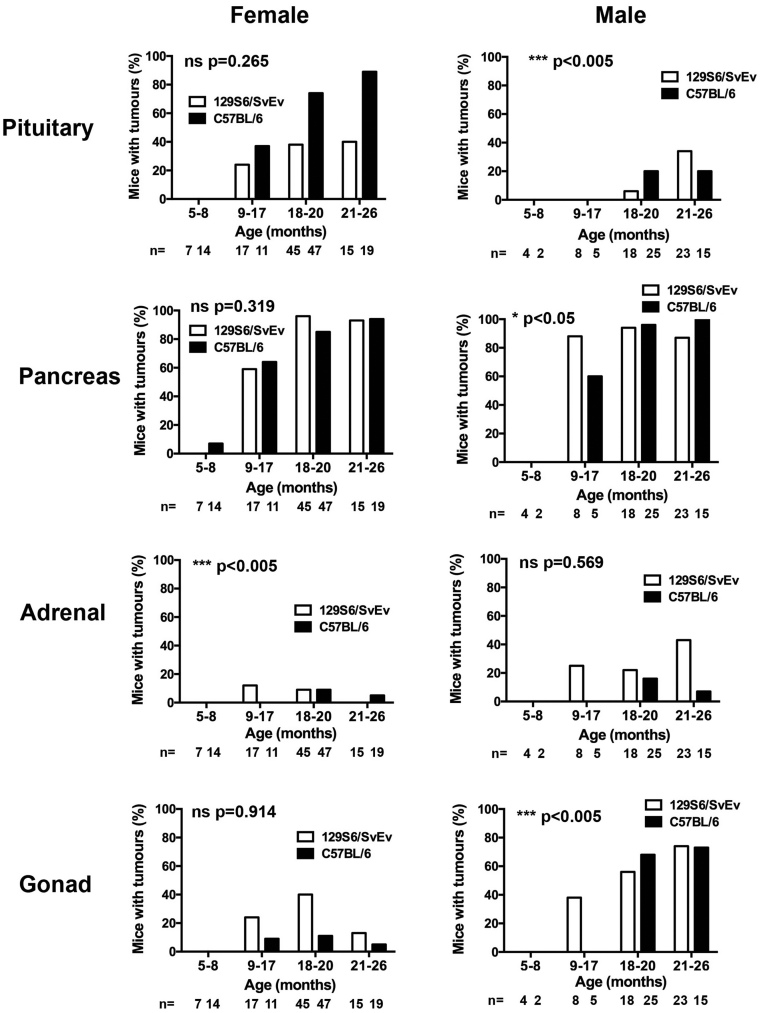
Age of tumour occurrence in endocrine organs of male and female congenic Men1+/- mice. The pituitary, pancreas, adrenals and gonads, which have previously been reported (19) to have significantly altered tumour development in 5- to 26-month-old 129S6/SvEv and C57BL/6 Men1+/- mice, were macroscopically examined for tumour development in four different age groups (5–8 months, 9–17 months, 18–20 months and 21–26 months) of Men1+/- mice, with the number (n) of mice per group. Differences in the of age of tumour development in 129S6/SvEv compared to C57BL/6 Men1+/- mice were assessed by Chi-squared test for trend.